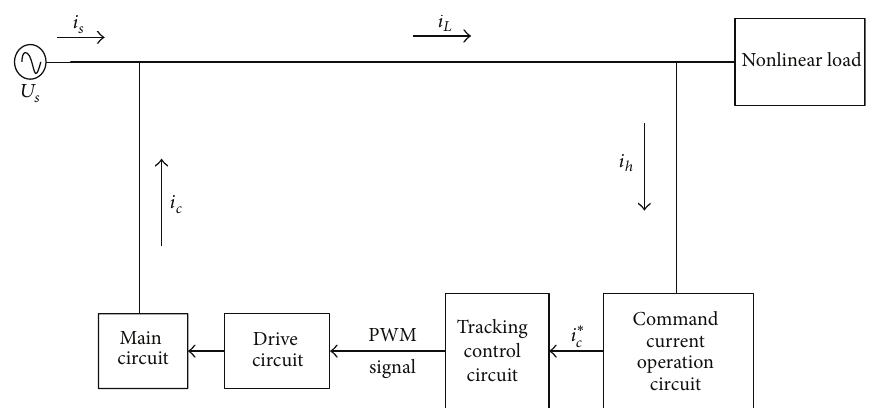
Figure 1: Schematic structure of shunt